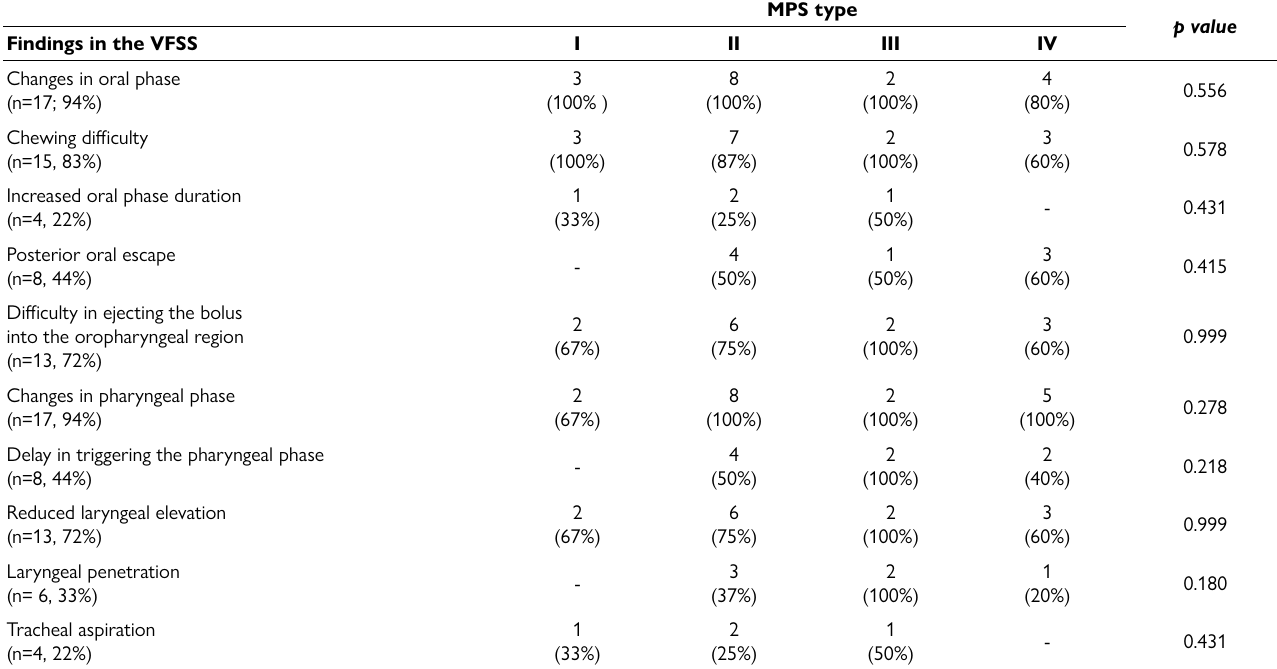
Table 3. Changes in oropharyngeal dysphagia in patients with MPS undergoing video fluoroscopic swallowing study (VFSS).